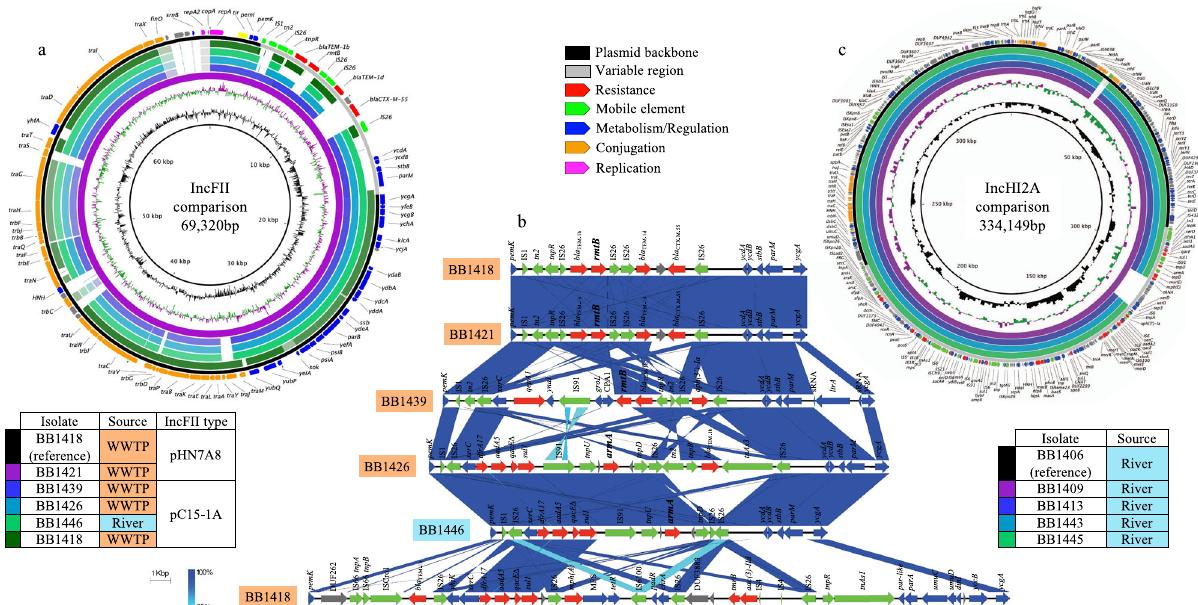
Fig. 5 Plasmid structure comparison of 16S-RMTase gene-carrying plasmids. a IncFII type plasmids comparison. From the inside out, the rings represent the reference plasmid (black inner ring), the GC content (black ring), the GC skew (purple/green ring), the compared plasmids (order, carrying isolate, source of the isolate, and IncFII plasmid type are shown in the table), backbone/variable region of the reference plasmid (black/gray ring) and genetic annotation for the reference plasmid (arrows are colored according to the functional groups indicated in the legend). b Pairwise comparison of the variable regions of IncFII plasmids. Names of carrying isolate are colored according to the source of the isolate. Gradient blue shades represent the sequence identity. Genetic annotation is represented by arrows and colored according to functional groups (legend). c IncHI2A type plasmids comparison. From the inside out, the rings represent the reference plasmid (black inner ring), the GC content (black ring), the GC skew (purple/green ring), the compared plasmids (order, carrying isolate and source of the isolate), backbone/variable region of the reference plasmid (black/gray ring) and genetic annotation for the reference plasmid (arrows are colored according to the functional groups indicated in the